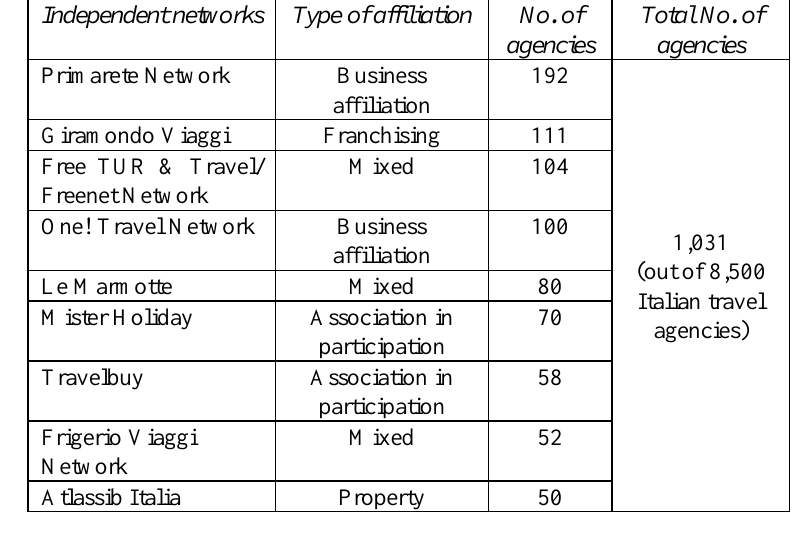
Table 1: Indipendent Network of travel agencies in Italy Independent networks Type of affiliation No. of Primarete